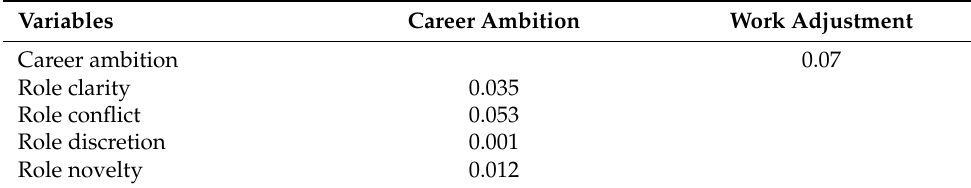
Table 7. Effect Size of Study